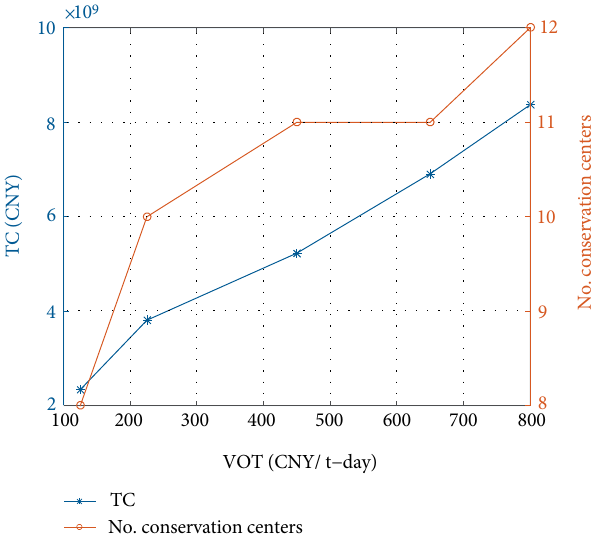
Figure 14: Impact of the value of time (VOT) on total cost ( the number of consolidation centers.